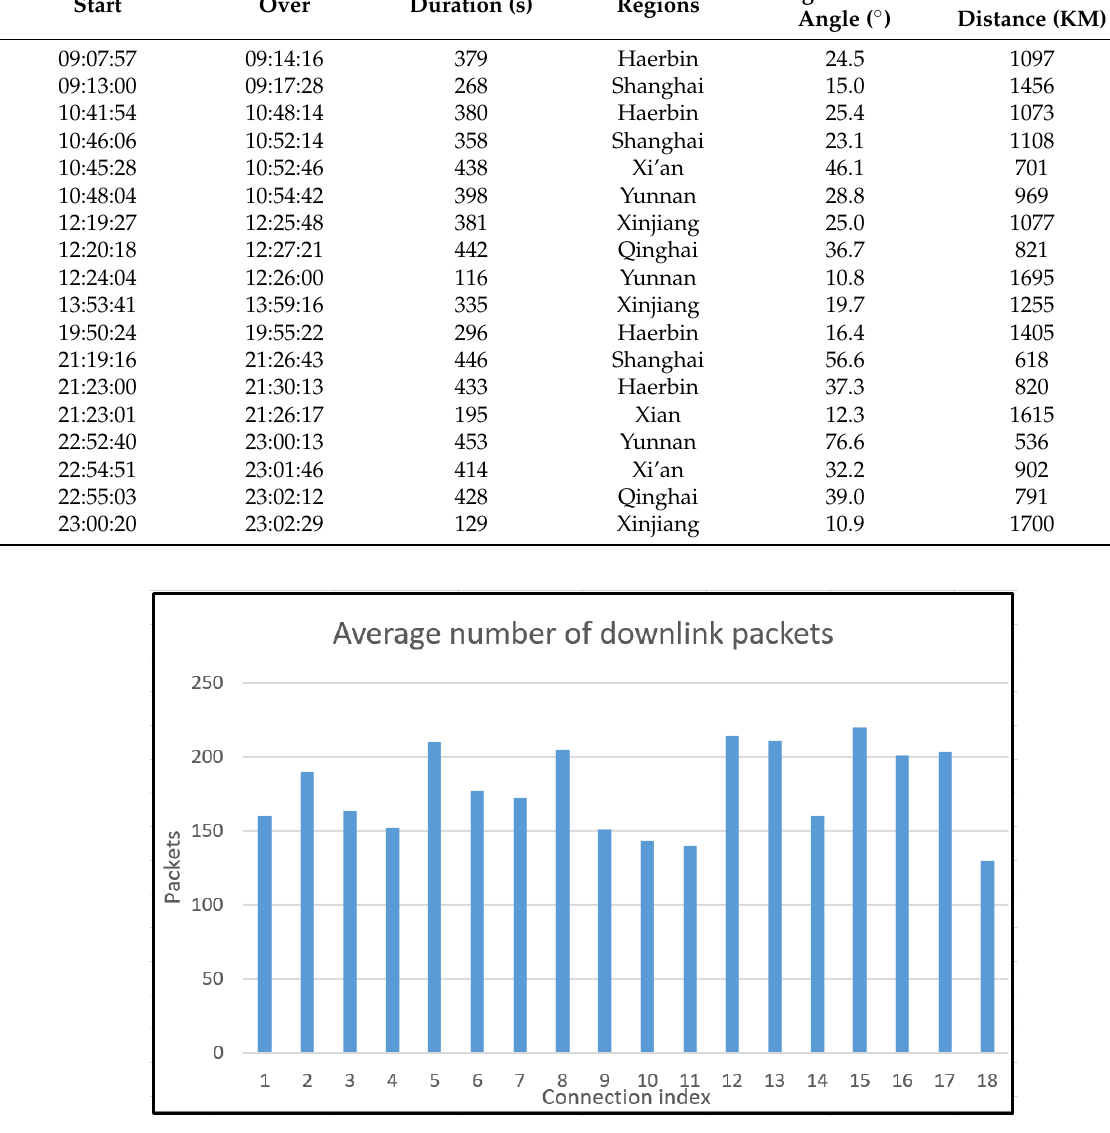
Figure 16. Average number of downlink packets of single CubeSat.